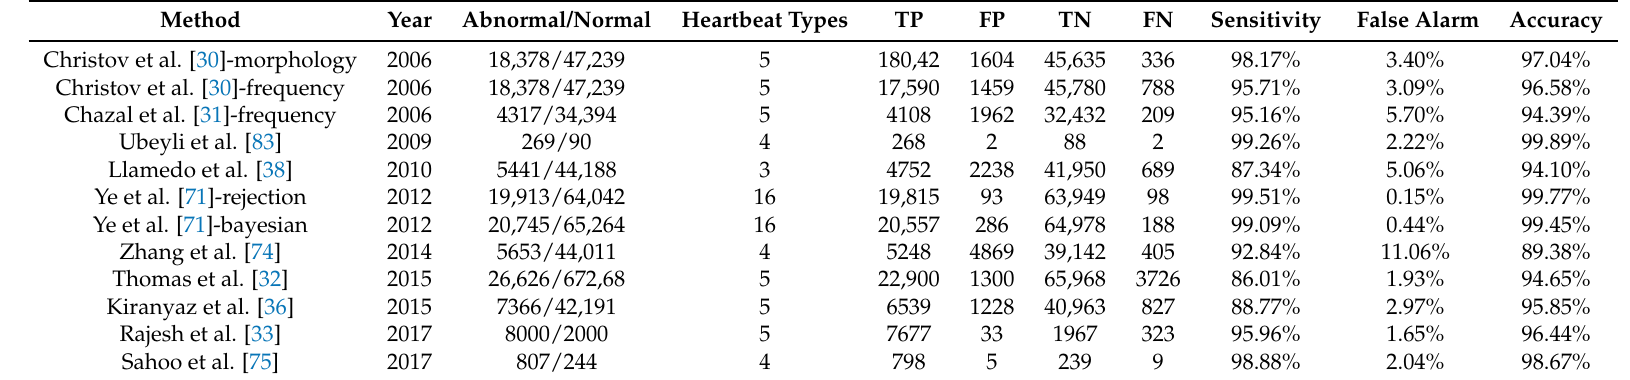
Table 4. Heartbeat classification performance on the MIT-BIH